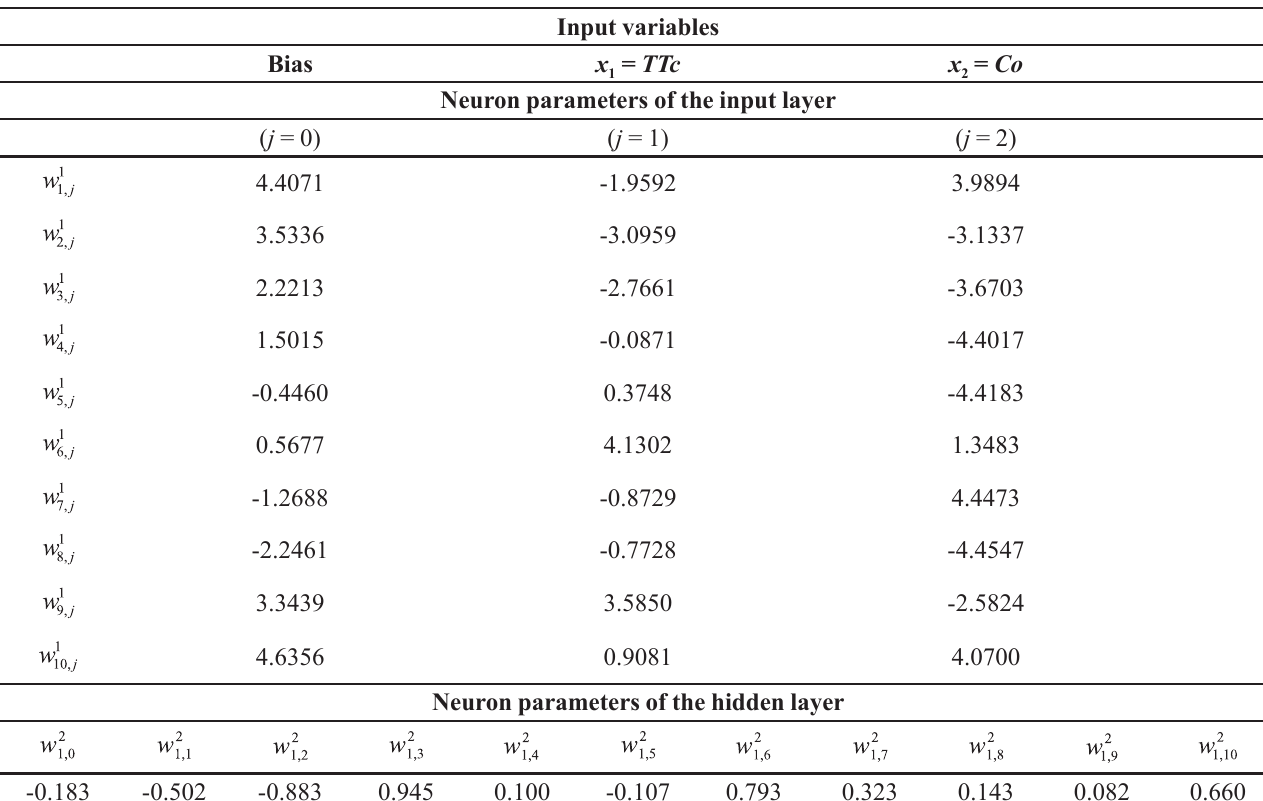
TABLE IX - Parameters found for ANN associated to data in Table V and Equation